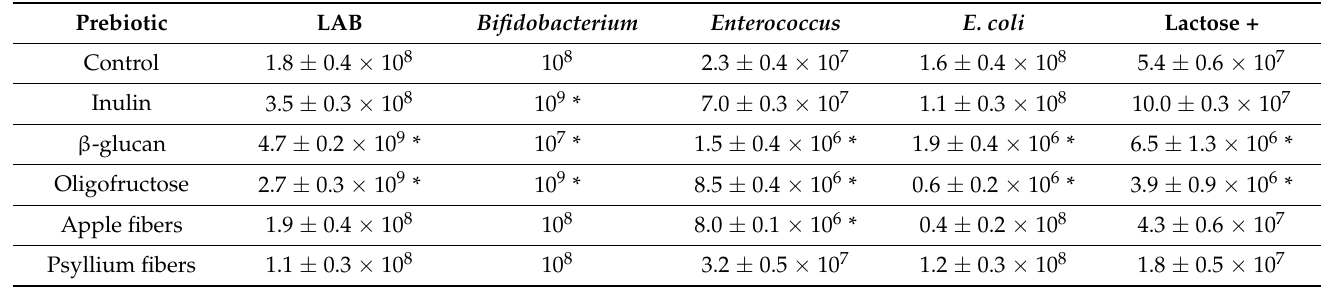
Table 1. Effect of various prebiotics on the number of intestinal micro-organisms in chickens, CFU/mL.